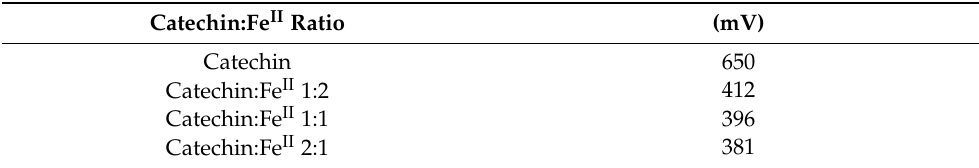
Figure 5. Differential pulse voltammograms of (±)-catechin, Fe II , and (±)-catechin:Fe II mixture solu- tions in phosphate buffer (pH 7.4). solutions in phosphate buffer (pH 7.4). Table 3. The electrode redox potential of the peak